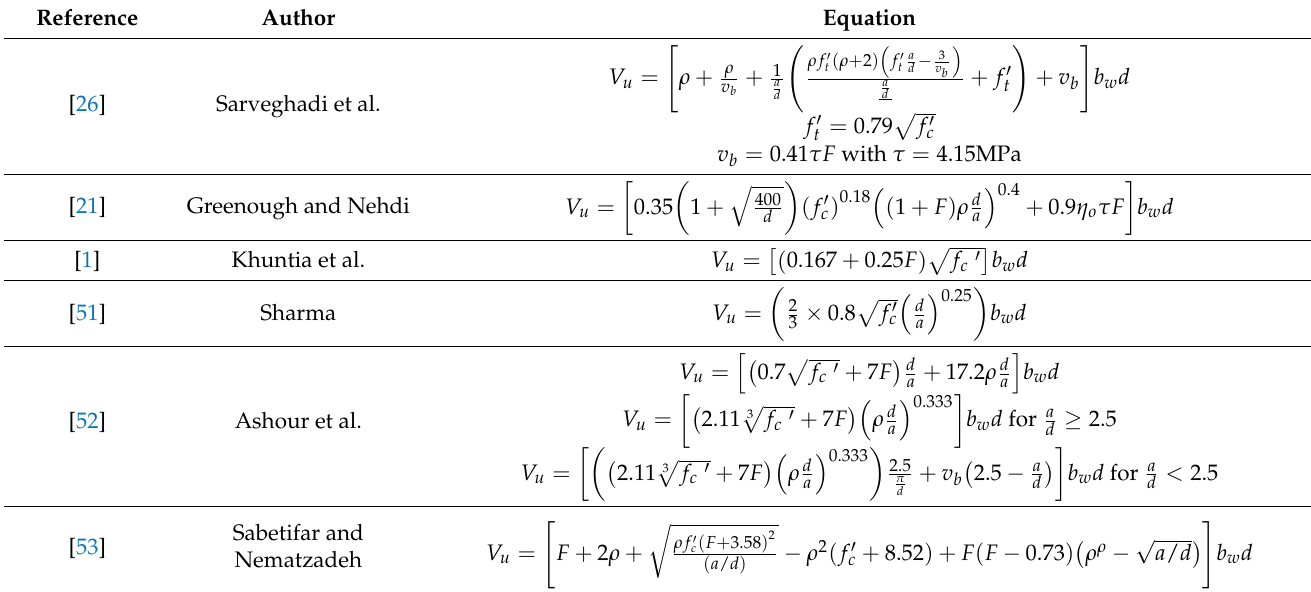
Table 6. Previous equations for the shear capacity of SFRC